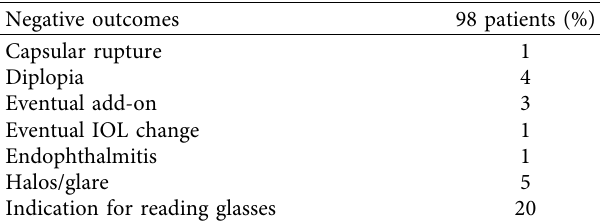
Table 2: Negative